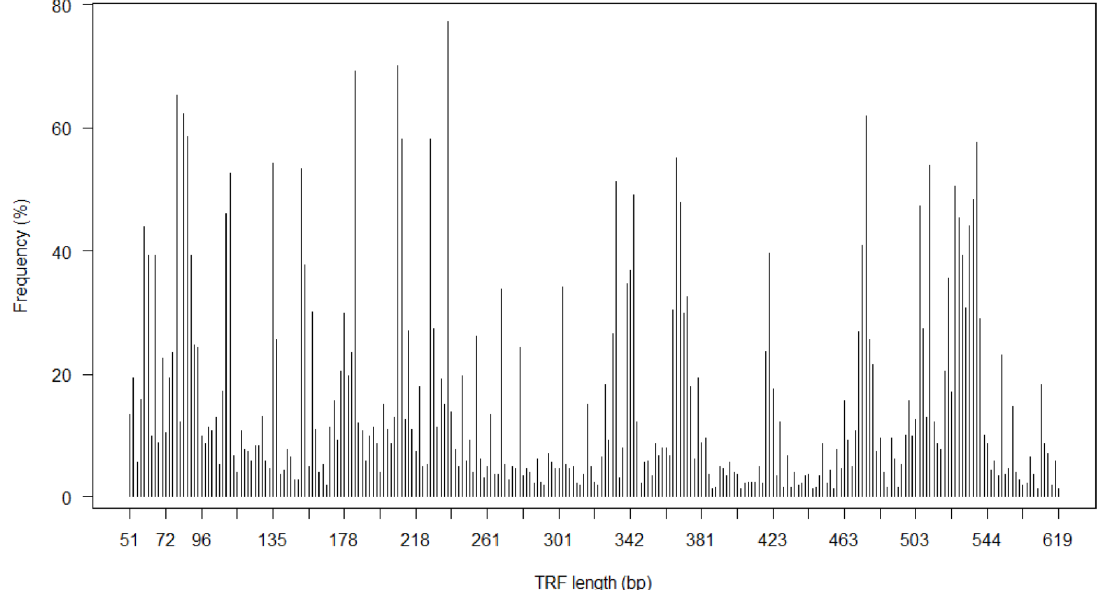
Figure 1. Nasopharyngeal bacterial richness in 1-month old children. Frequency of terminal restriction fragments (TRFs) obtained by HhaI cleavage of 16S rRNA gene isolated from nasopharyngeal swab specimens of 328 asymptomatic 1-month old neonates. The TRFs are displayed after binning and alignment of TRFs from individual samples.